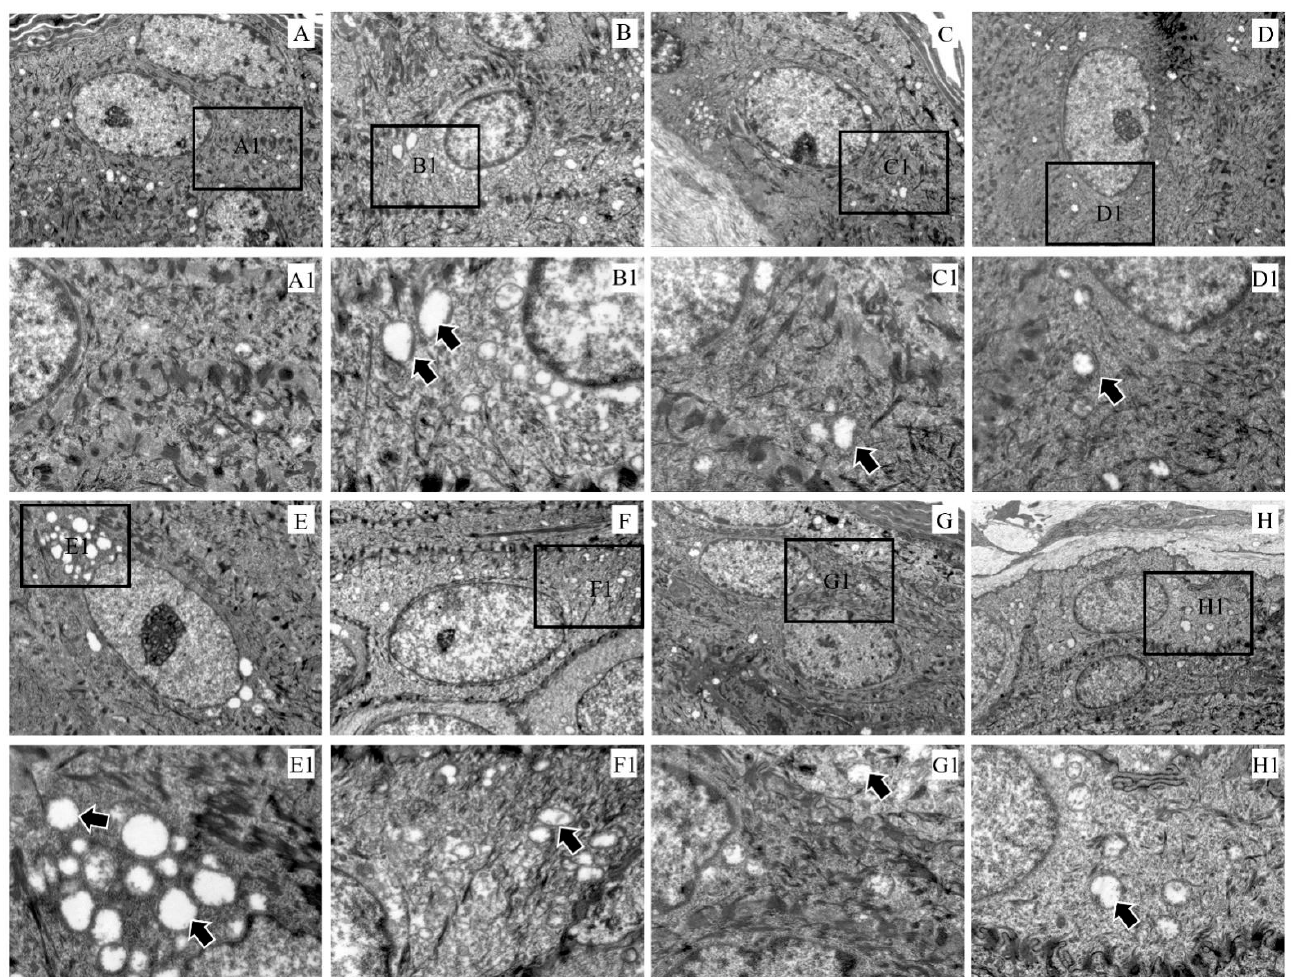
Figure 4. Ultramicropathology of the epidermis of rabbit skin. (A): Control, (B): 6 hpi, (C): 12 hpi, (D): 1 dpi, (E): 3 dpi, (F): 1 wpi, (G): 4 wpi, (H): 8wpi. Figures (A1–H1) (×3000) represent the enlarged figure of the black frame in figures ( A – H ) ( × 8000). The arrows point to mitochondrial